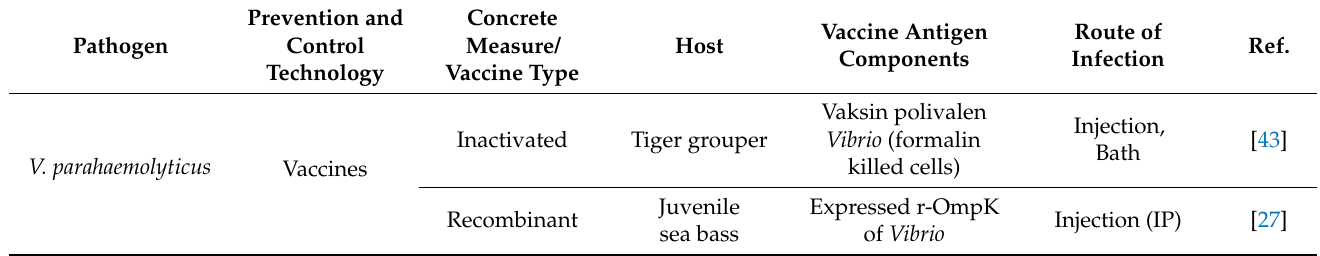
Table 3. Control and prevention strategies of V. parahaemolyticus. NR: Not